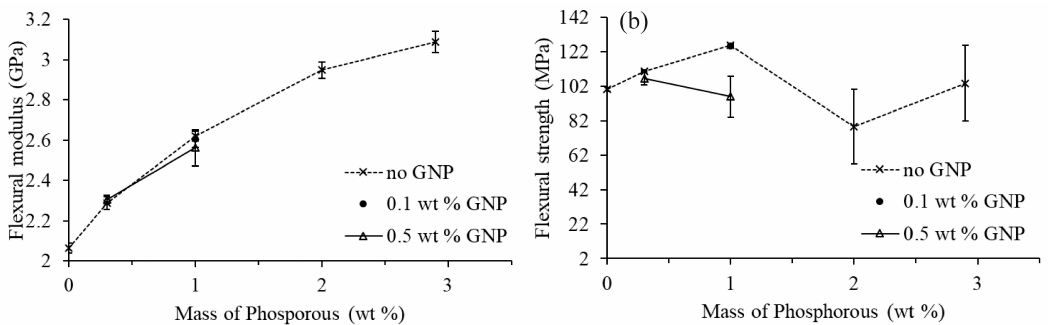
Figure 5. Effect of DOPO on the ( a ) flexural modulus and ( b ) flexural strength of DOPO-incorporated epoxy nanocomposites.